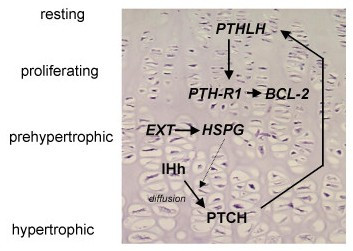
Growth plate signaling in the normal growth plate. Indian Hedgehog protein (IHh) is expressed in the prehypertrophic cells, and diffuses over a variable distance to its receptor Patched (PTCH). Subsequently, increased secretion of ParaThyroid Hormone Like Hormone (PTHLH) is induced at the apical perichondrium via an incompletely understood mechanism. PTHLH then diffuses to its receptor, whose expression is restricted to the late proliferating chondrocytes, inhibiting their further differentiation, resulting in less IHh producing cells, which closes the feedback loop. Thus, PTHLH regulates the pace of chondrocyte differentiation by delaying the progression of chondrocytes towards the hypertrophic zone, allowing longitudinal bone growth. Defective or absent EXT proteins leading to altered or absent HSPG expression at the cell surface may affect this negative feedback loop by disturbing the diffusion of IHh, produced at the pre-hypertrophic chondrocytes, towards its receptor Ptc.